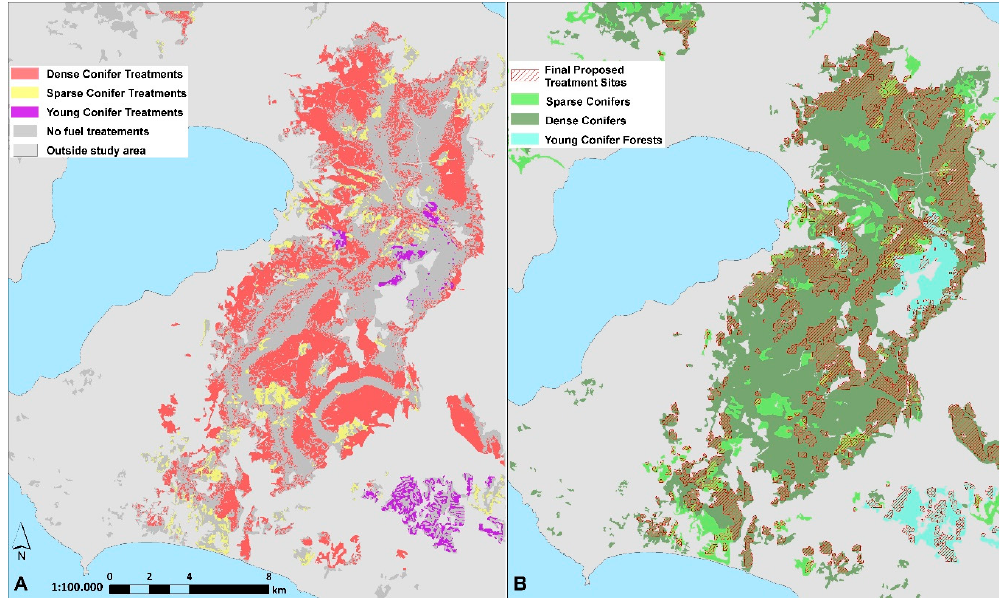
Figure 6. ( A ) Modifications of canopy cover characteristics for generating the ideal landscape on dense, sparse, and young conifer forests (red, yellow, and purple areas, respectively); ( B ) optimum fuel treatment areas (red dashed polygons) inside conifer forests where the combined canopy and surface treatments can reduce wildfire behavior, as calculated by TOM. treatments can reduce wildfire behavior, as calculated by TOM.